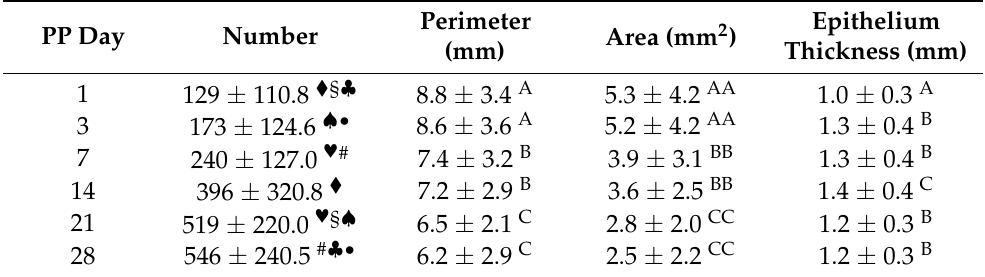
Table 2. Postpartum endometrial glandular number, perimeter, area, and epithelium thickness (mean ± SD) in the different sampling times in the 9 Martina Franca jennies.